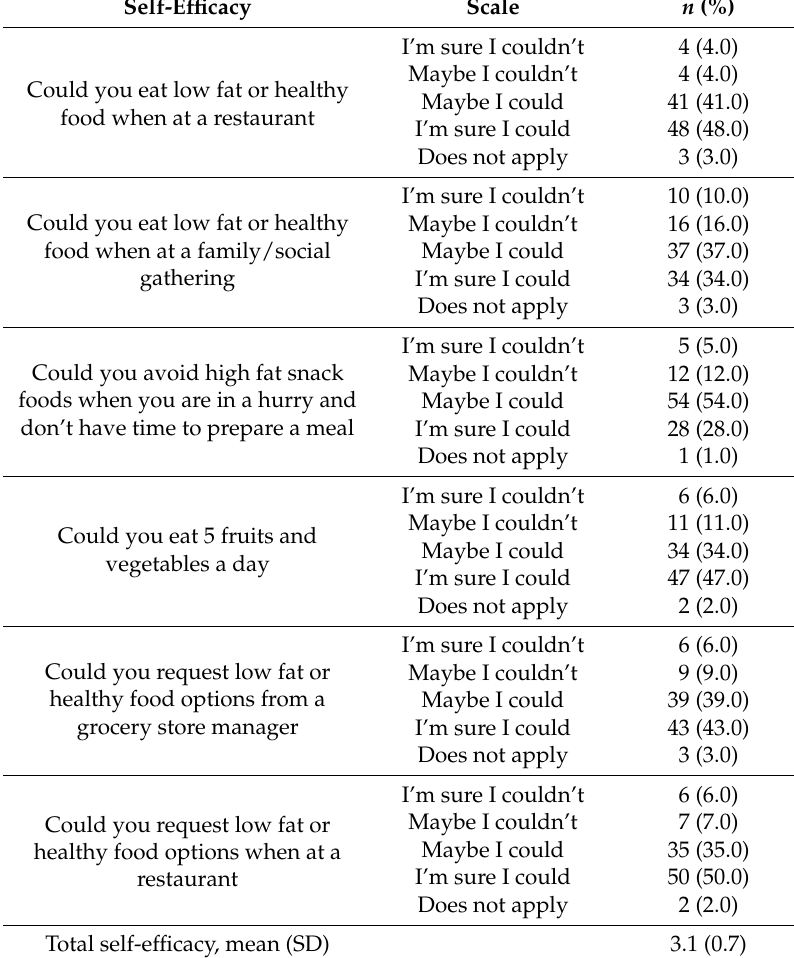
Table 4. Participants’ self-reported of self-efficacy toward healthy eating ( n =